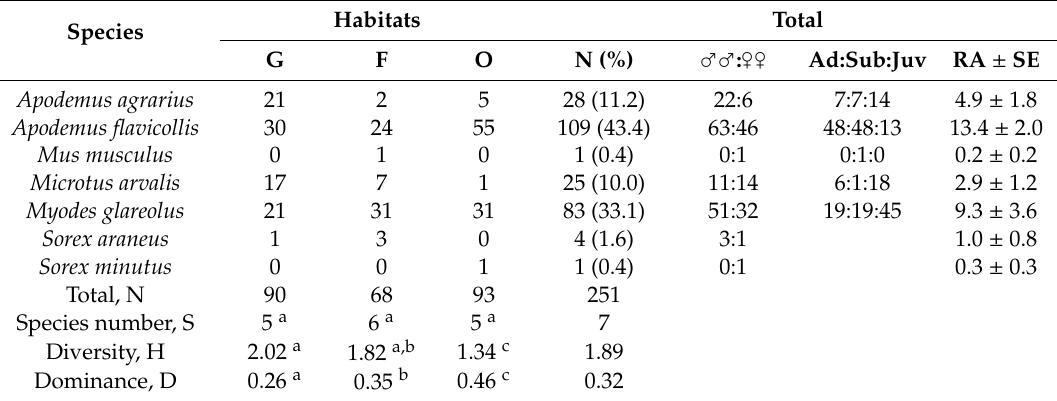
Table 1. Composition of the anthropophilic small mammal communities in commensal